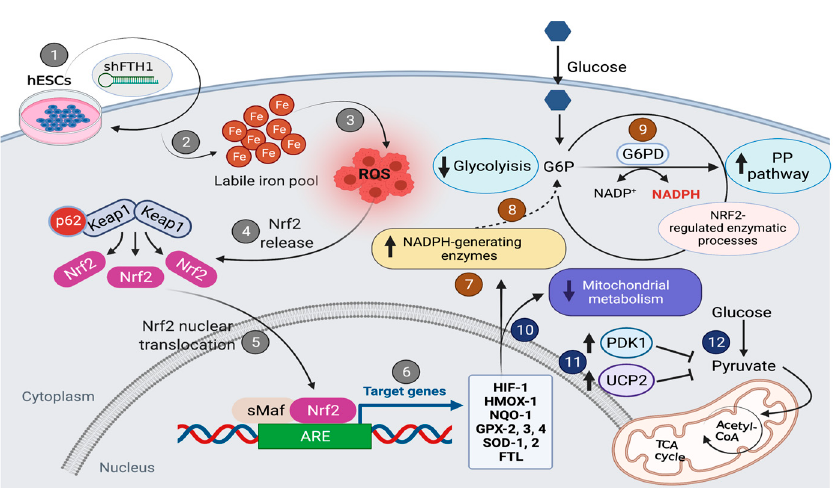
Figure 6. Schematic diagram illustrating oxidative stress response mediated by FTH1 downregulation in hESCs. FTH1 (1) is the master scavenger molecule for intracellular iron homeostasis and its inactivation leads to imbalanced redox homeostasis due to intracellular iron accumulation (2) and ROS production (3). Surprisingly, in hESCs, a reduced expression of FTH1 expression is not associated with oxidative stress and ROS production. This phenomenon can be explained by three crucial findings: first, FTH1-silenced hESCs showed an enhanced transcriptional activity of Nrf2 (4–5) on key antioxidant target genes such as HIF-1 , HMOX-1 , NQO-1 , GPX2/3/4 , SOD1/2 , FTL (6); second, we observed the activation of an alternative metabolic program from glycolysis (7–8) to pentose phosphate pathway (PPP) where the activity of the G6PD enzyme ensures the conversion of NADP+ to NADPH (9) involved in ROS neutralization; third, the mitochondrial metabolism was found to be inactive (10) in FTH1-silenced hESCs, as demonstrated by the upregulation of PDK1 and UCP2 genes (11), specifically involved in preventing pyruvate from entering the tricarboxylic acid cycle (TCA) (12).